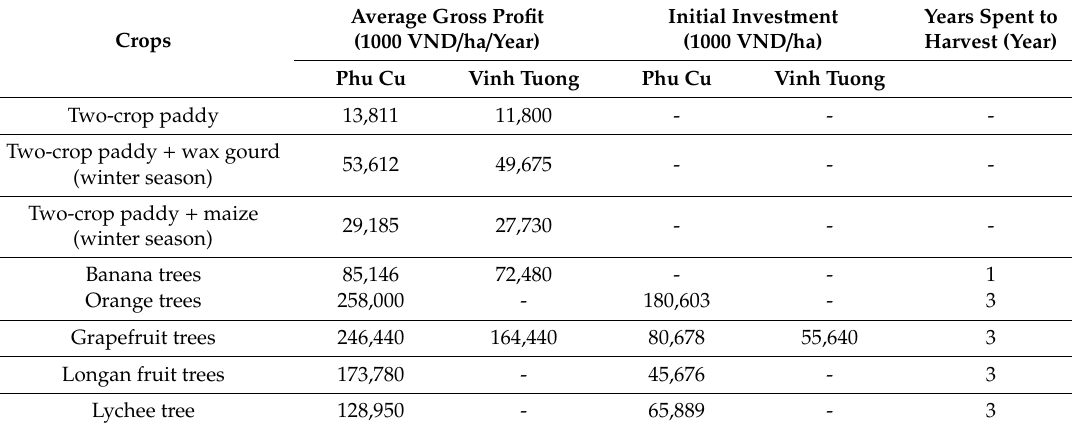
Table 8. Comparison of profits from the main annual and perennial crops in the research areas.